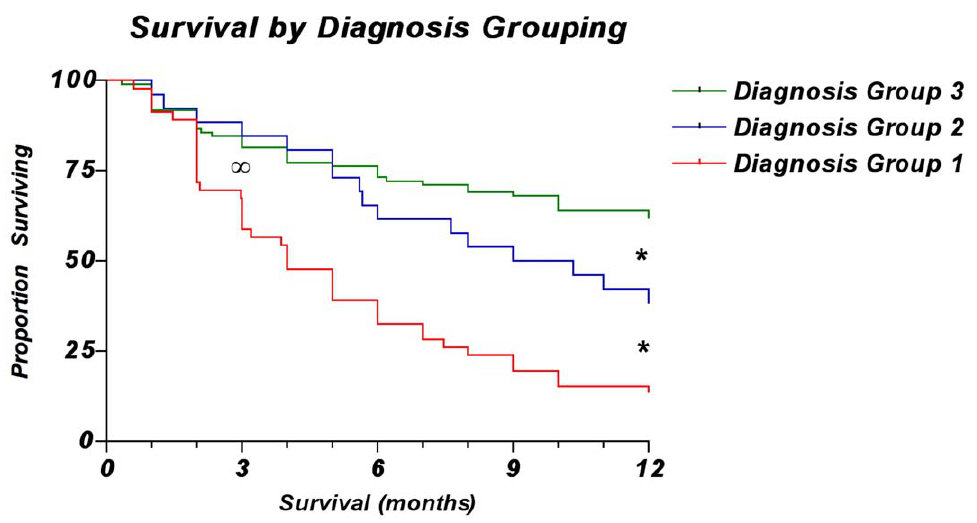
Figure 1. Kaplan-Meier curves showing overall survival for patients by diagnosis group. The overall survival of patients in Group 1 was significantly lower than that of patients in Groups 2 and 3 at the 3-month time point ‘ ( p , 0.0001, log-rank test). Overall survival was significantly